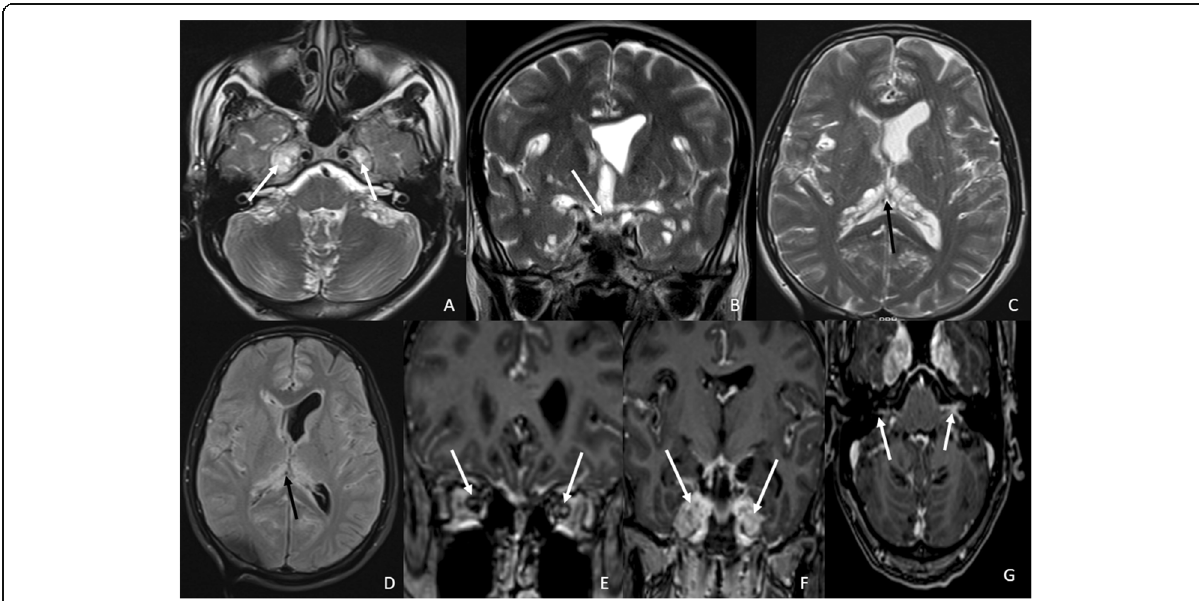
Fig. 4 Follow-up magnetic resonance imaging of the brain at our institute 8 months after the onset of the symptoms. A T2W axial image of the brain at the level of the Meckel ’ s caves shows ballooning of the Meckel ’ s cave bilaterally. The white arrows point towards the ballooning of bilateral Mecksl ’ s caves. B T2W coronal image of the brain at the level of the optic chiasm shows expanded chiasmatic cistern with displaced optic chiasm. The white arrow points towards the displaced optic chiasm. C T2W axial image of the brain at the level of the velum interpositum. There is expansion of the velum interpositum with hyperintense signal as demonstrated with black arrow. D Axial FLAIR image of the brain at the level of velum interpositum shows no signal suppression in the velum intrepositum on FLAIR, as pointed out with black arrow, in comparison with T2W image shown in C . E Post-contrast T1W coronal image of the brain at the level of the orbits depicts enhancement along bilateral optic nerves as pointed out with white arrows. F Post-contrast T1W coronal image at the level of the Meckel ’ s cave shows avid enhancement is noted along bilateral Meckel ’ s caves and internal acoustic canals as shown with the help of white arrows. G Post-contrast T1W axial image at the level of the internal acoustic canals showing avid contrast enhancement along the bilateral Meckel ’ s caves and the internal acoustic canals as demonastrated with white arrows